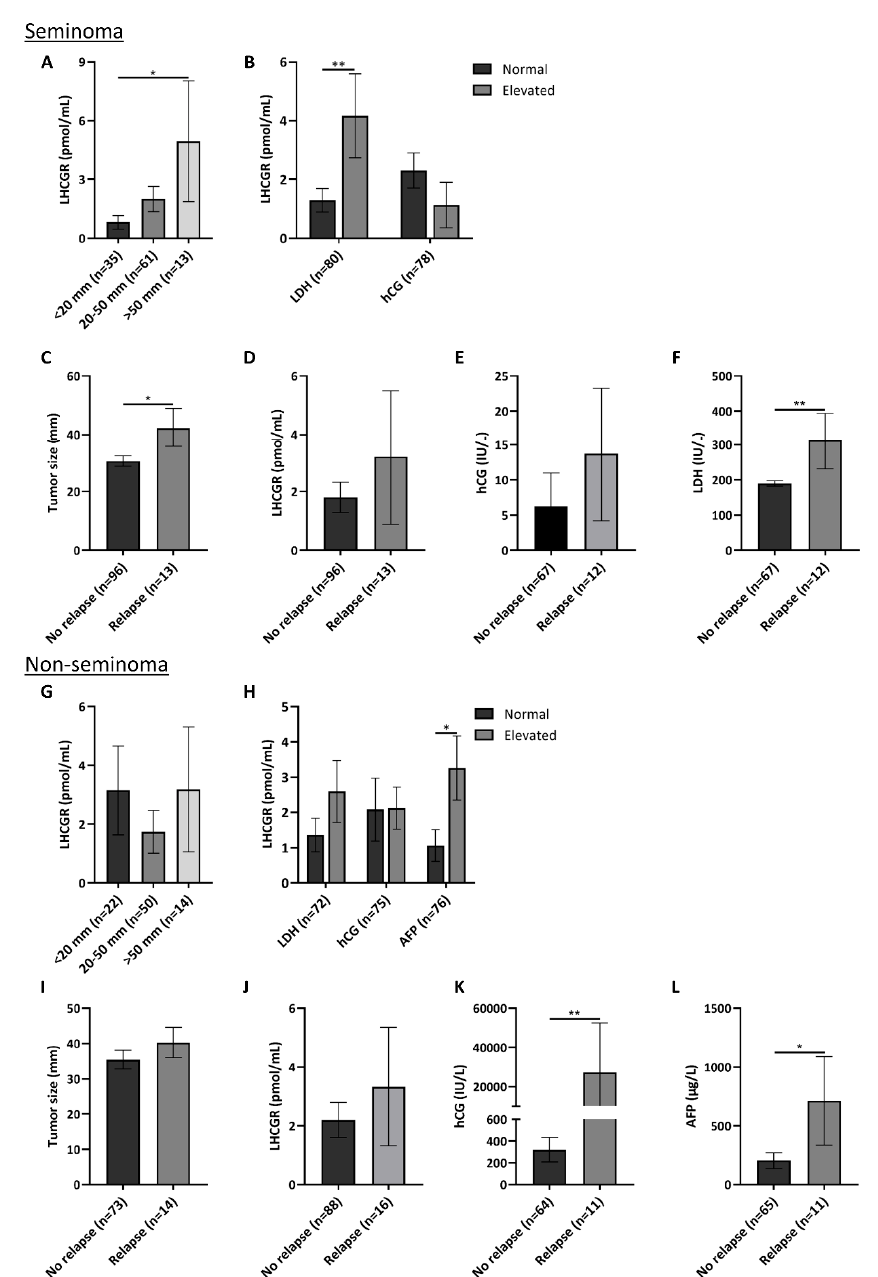
Figure 4. Serum LHCGR is associated with LDH and tumor size in patients with seminoma. ( A , B ) LHCGR serum levels were analyzed in patients with seminoma stratified according to tumor size ( A ) and serum LDH ( < 205 vs. ≥ 205 U / L) and hCG ( < 3 vs. ≥ 3 IU / L) levels ( B ). ( C – F ) Tumor size ( C ) and serum levels of LHCGR ( D ), hCG ( E ), and LDH ( F ) were measured in patients with seminoma stratified into groups depending on whether they had experienced a relapse or not. ( G , H ) LHCGR serum levels were analyzed in patients with non-seminoma stratified according to tumor size ( G ) and serum LDH ( < 205 vs. ≥ 205 U / L), hCG ( < 3 vs. ≥ 3 IU / L) and AFP ( < 12 vs. ≥ 12 × 10 3 IU / L) levels ( H ). ( I , L ) Tumor size ( I ) and serum levels of LHCGR ( J ), hCG ( K ), and AFP ( L ) were measured in patients with non-seminoma stratified into groups depending on whether they had experienced a relapse or not. Values represent mean ± SEM. * p < 0.05, ** p < 0.01. Abbreviations: AFP, Alpha-fetoprotein; hCG, human chorionic gonadotropin; LDH,lactatedehydrogenase; LHCGR,luteinizinghormone /